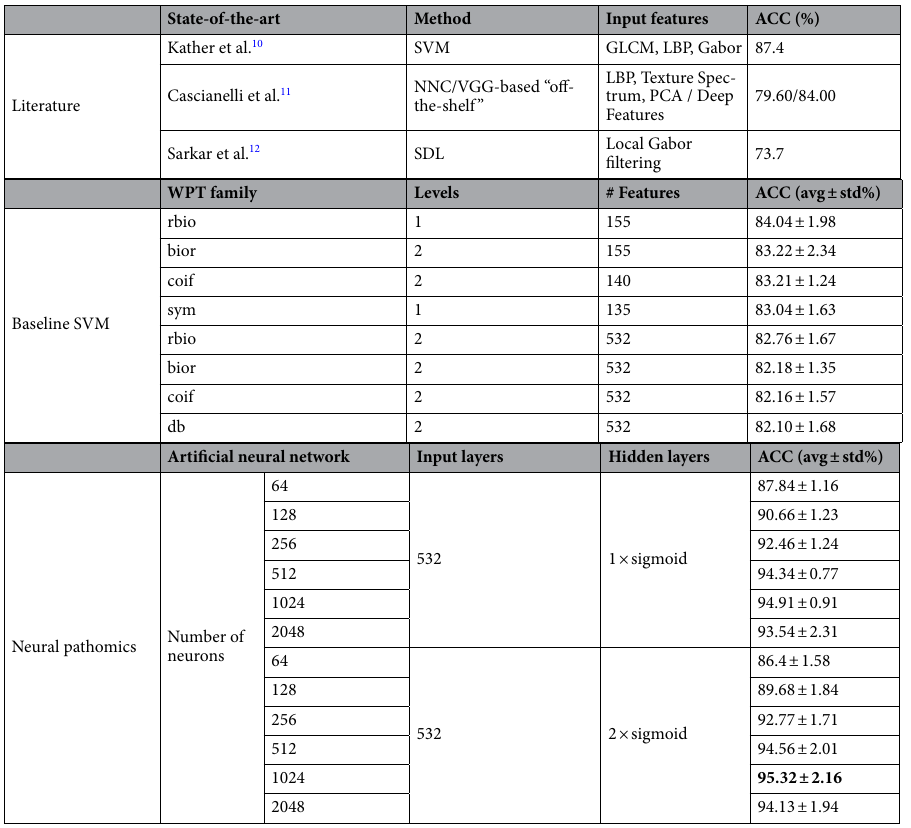
Table 1. Performance analysis of the current literature in comparison to the tenfold average accuracy of the examined SVM-based and ANN models. Bold font indicates the best